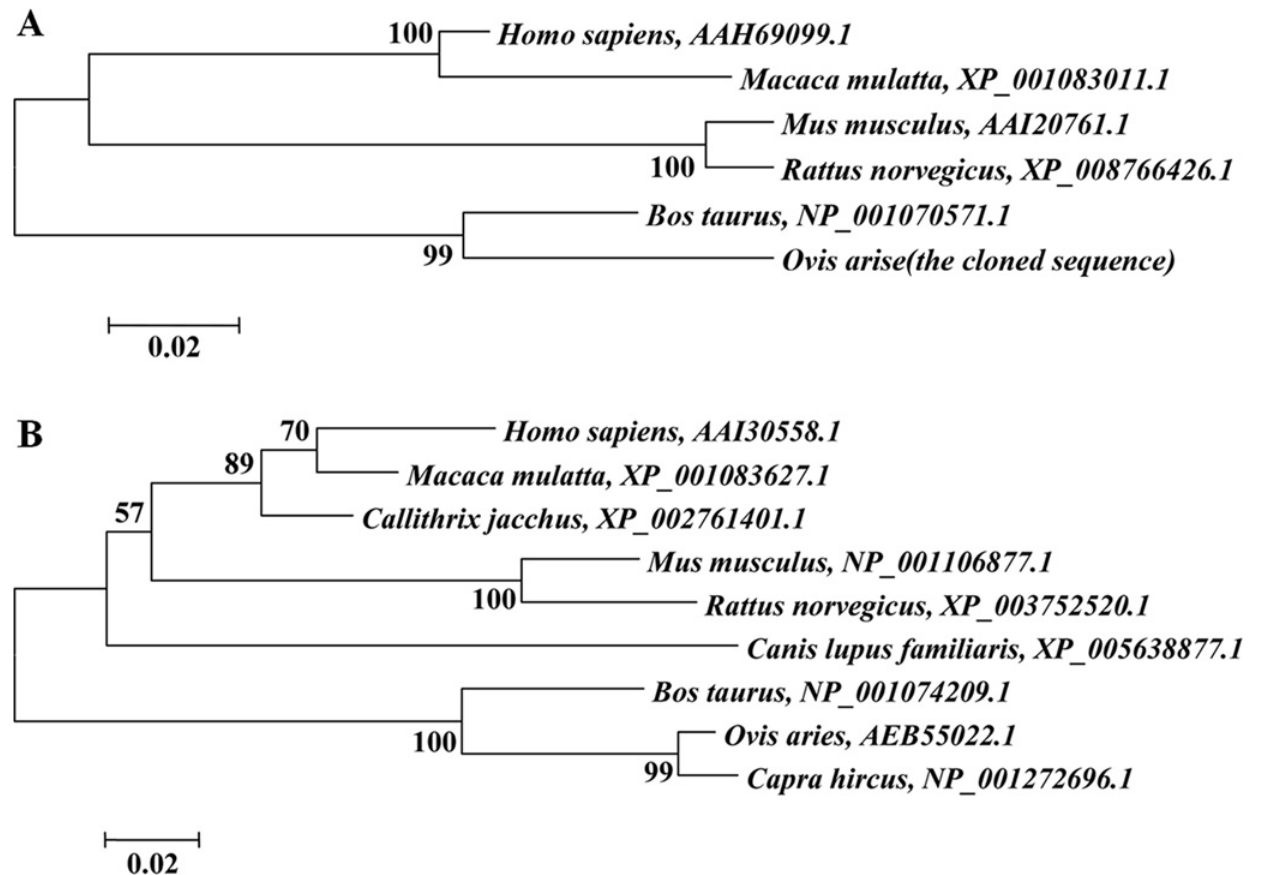
Fig 2. Phylogenetic tree based on the amino acid sequences of the KAP3-3 and KAP11-1 proteins from sheep and other species. (A) KAP3-3. (B) KAP11-1.